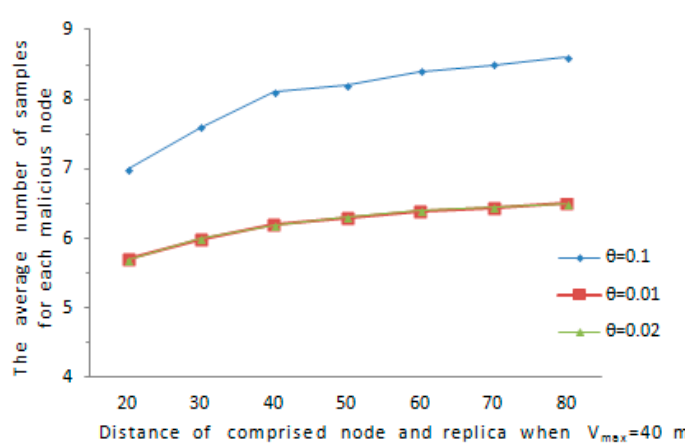
Figure 11. The average number of samples versus D when V max = 40 m/s.